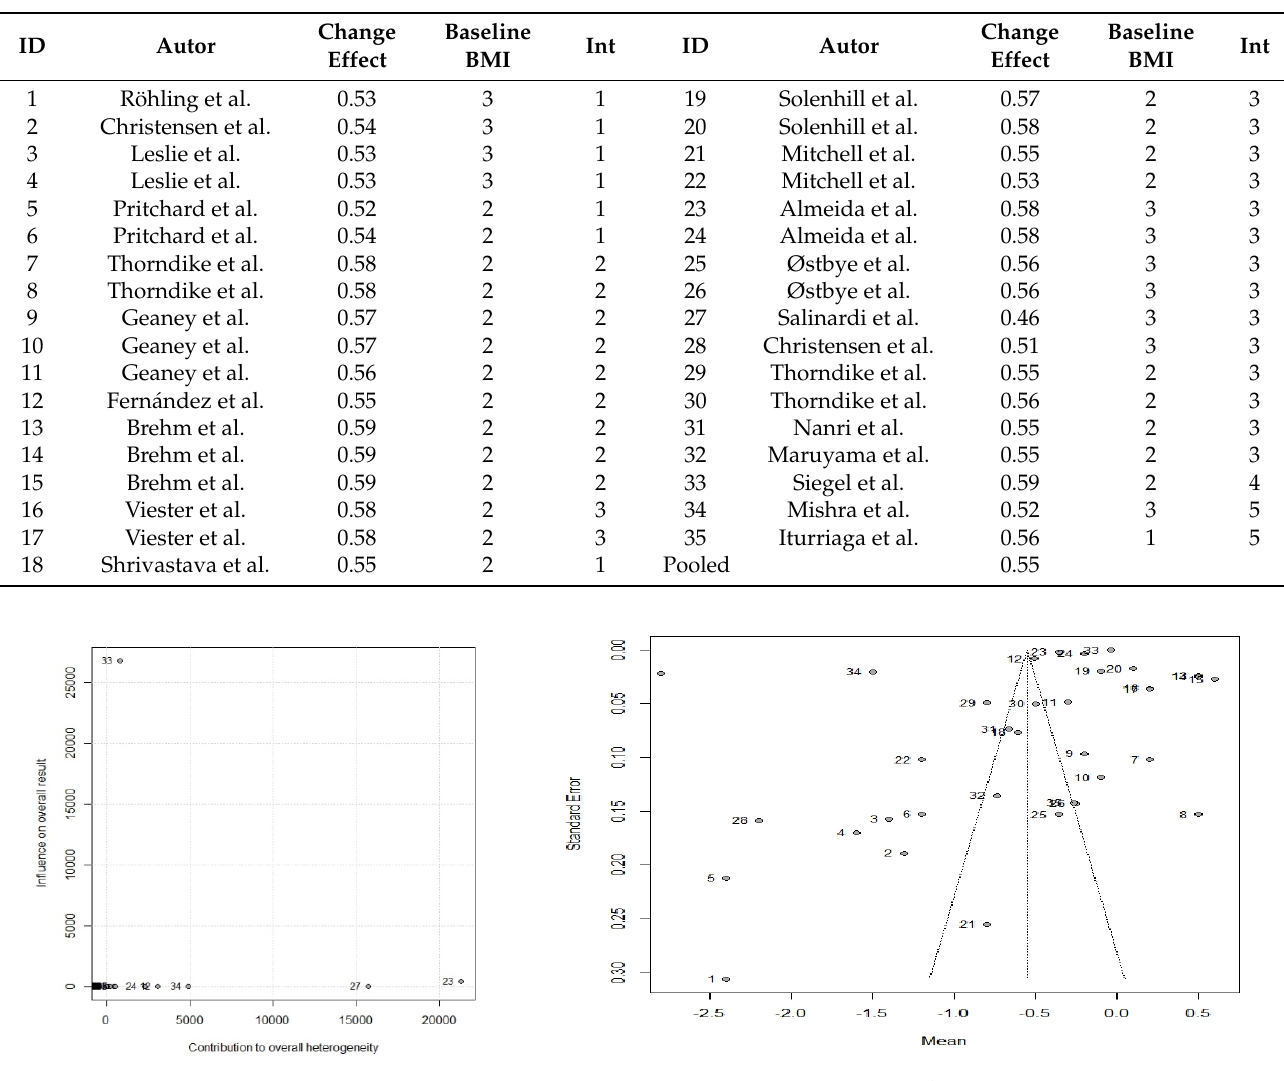
Table 3. Summary leave-one-out, Baseline of Body Mass Index and interventions.